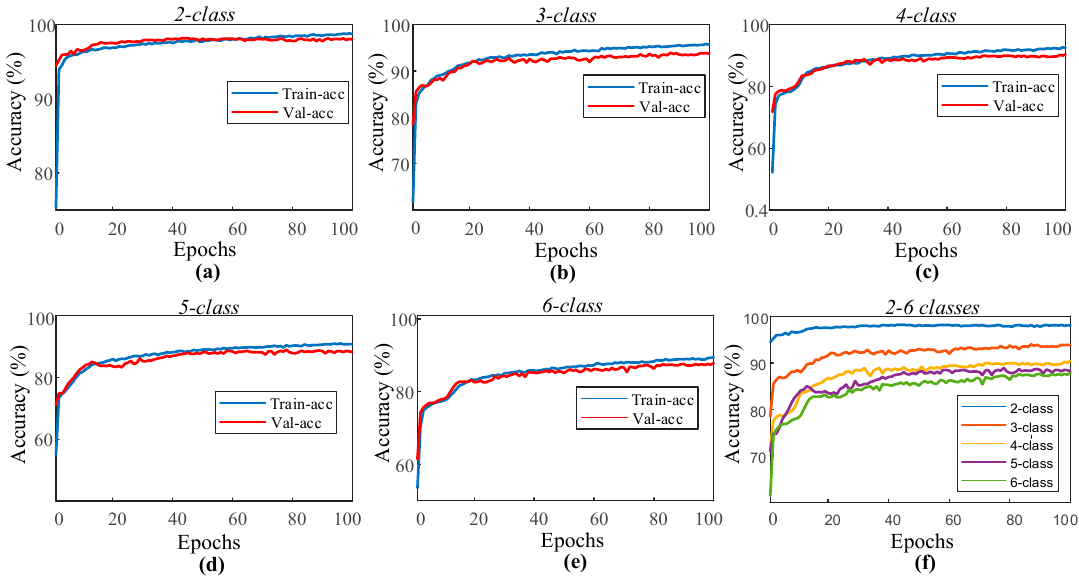
Figure 4. Performance graphs of the proposed 1D-CNN model with the single EOG signal for the sleep-edf dataset: ( a ) two-class model, ( b ) three-class model, ( c ) four-class model, ( d ) five-class model, ( e ) six-class model, and ( f ) validation accuracy for the models with two to six classes.